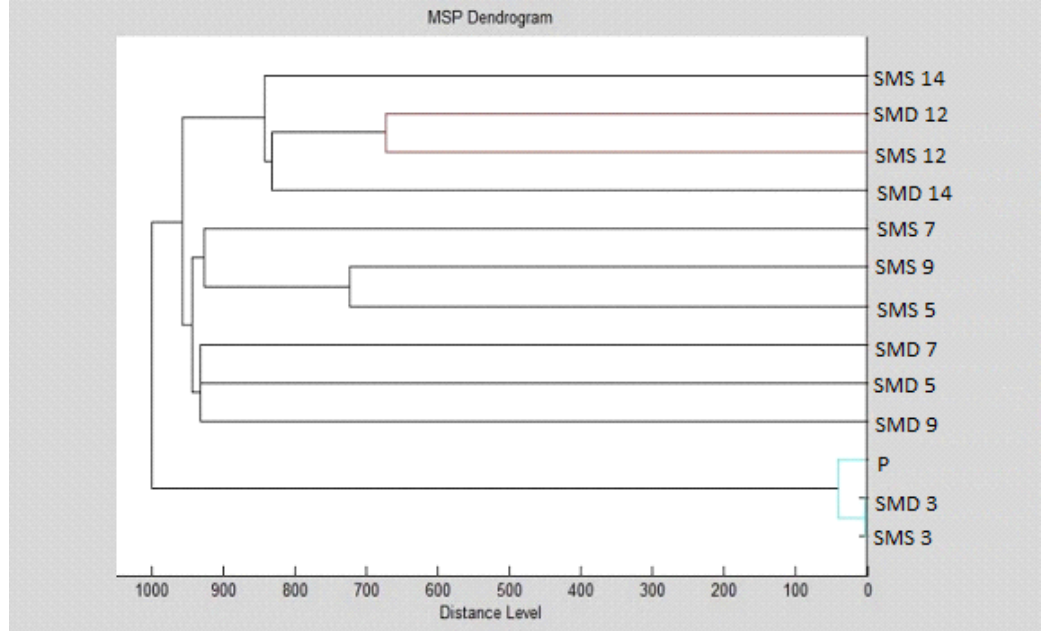
Figure 3. Dendrogram of S . maltophilia generated using the standard global spectrums (MSPs) for planktonic cells and control: K-control; S- Stenotrophomonas maltophilia ; P-planktonic cells. MSP grouping of S. maltophilia for planktonic cells and all experimental groups showed that the young P, SMD 3 and SMS 3 biofilms were the most distant group, while the biofilm formation profile of S. maltophilia was balanced in the grouping manner (Figure 4).